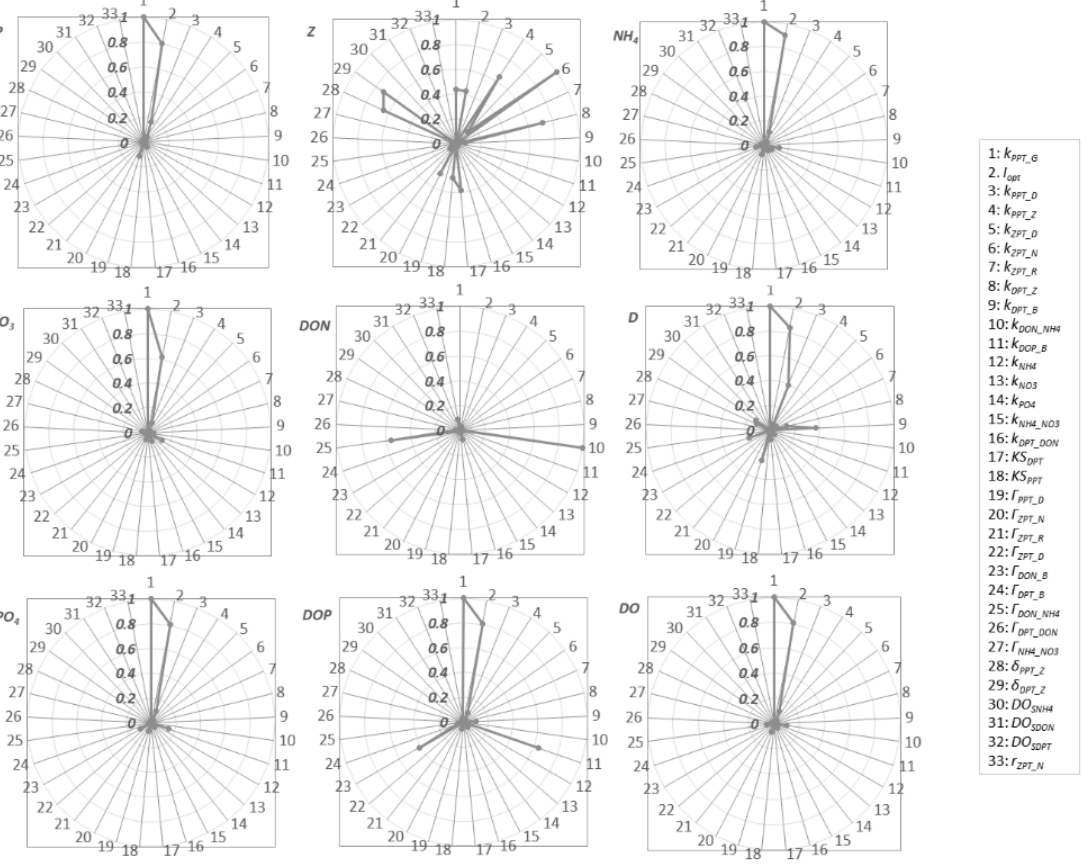
Figure 6. GSA results of different parameters and their impact on different state variables. P , Z , NH 4 , NO 3 , DON , D , PO 4 , DOP , and DO represent phytoplankton, zooplankton, ammonium, nitrate,